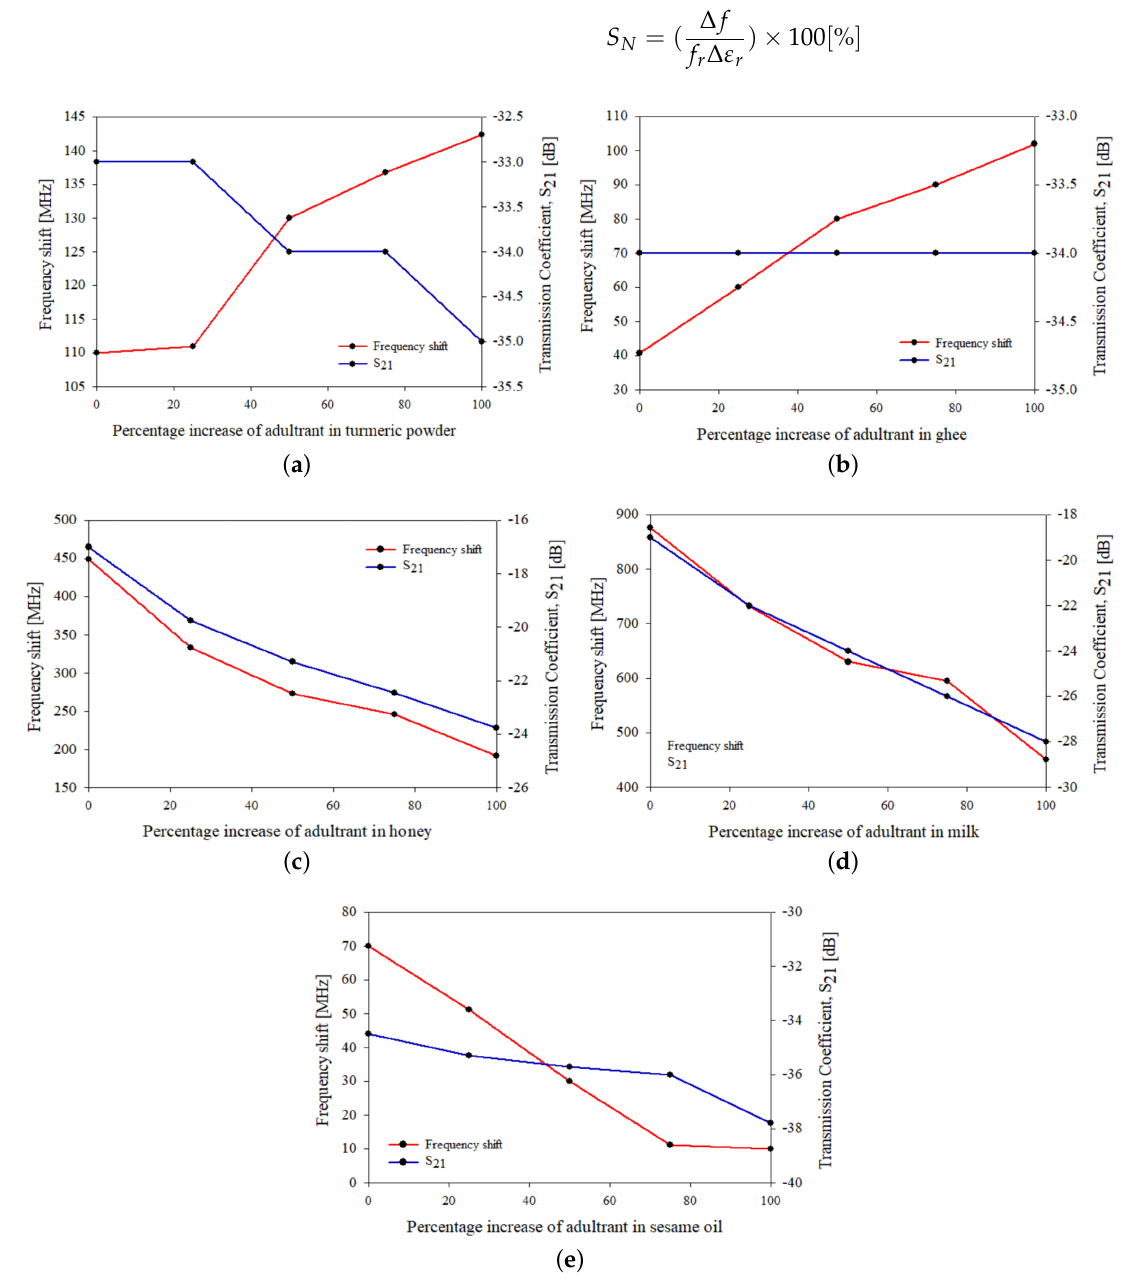
Figure 33. Variation in resonant frequency and transmission coefficient on adding adulterant to ( a ) turmeric powder, ( b ) ghee, ( c ) honey, ( d ) milk and ( e ) sesame